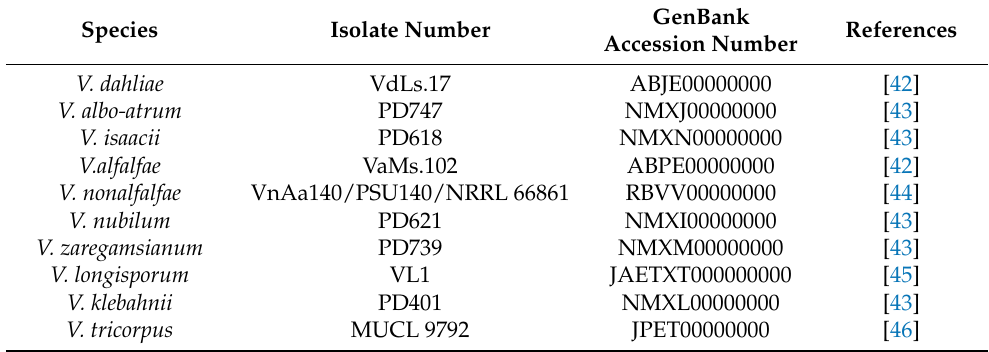
Table 1. Isolates numbers and genome sequence information for the species used in this study. Species Isolate Number